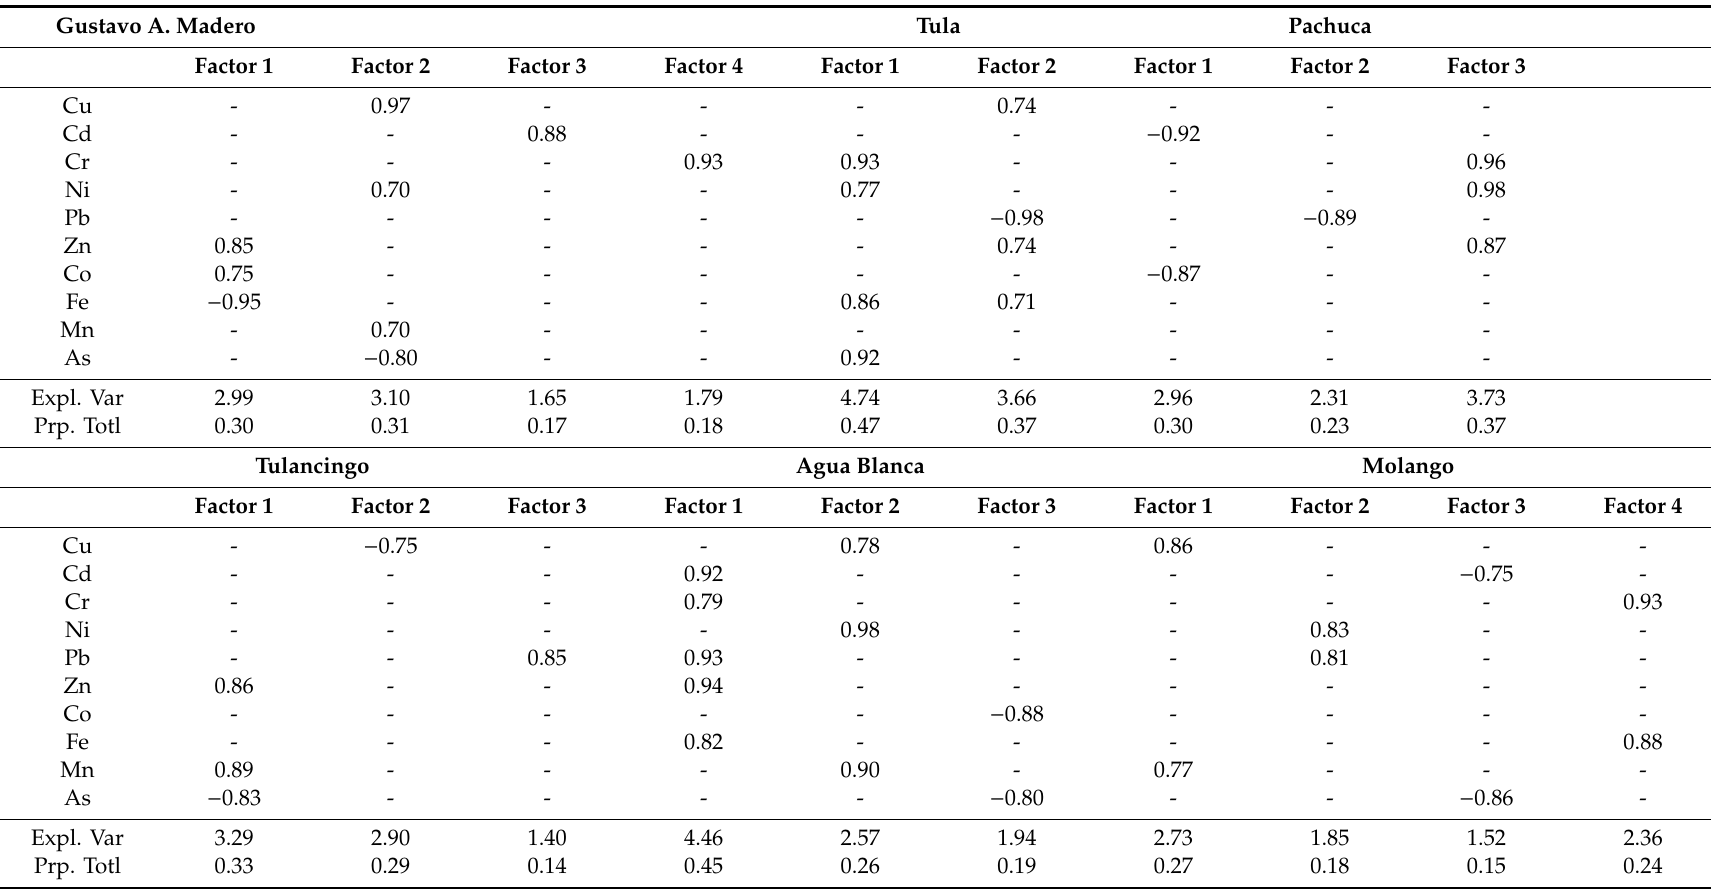
Table 5. Factor loading normalized with VARIMAX